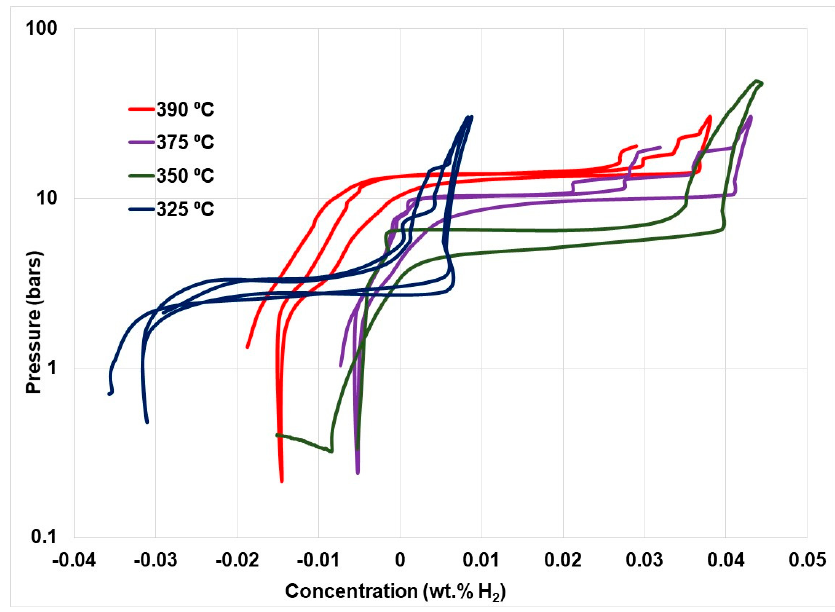
Figure 11. Pressure–composition isotherms of LiBH 4 + ½nanoMgH 2 + 3 mol% nanoNi .